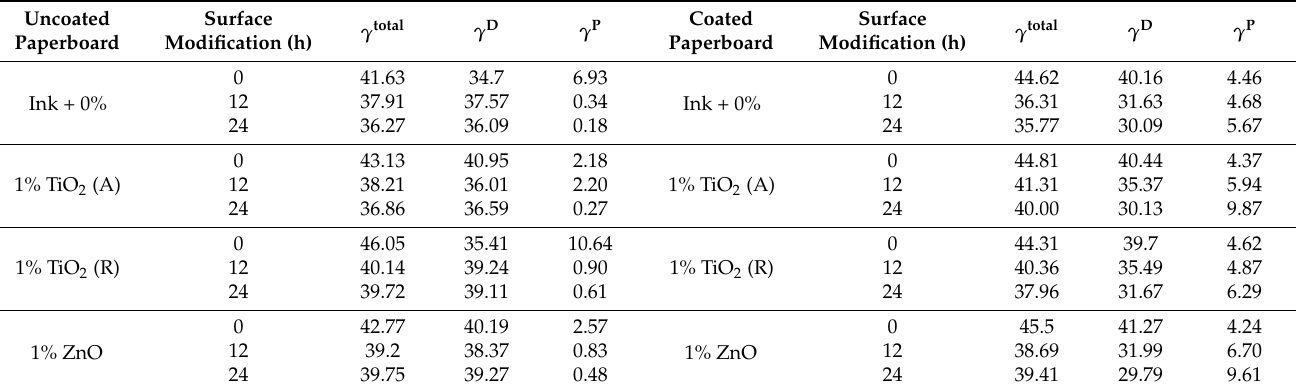
Table 7. Results of the SFE of ink films.